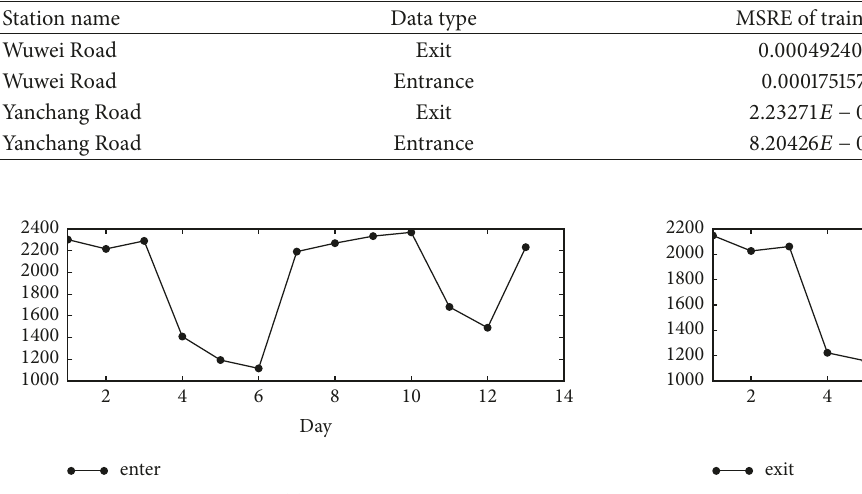
Table 11: Training error and test error of prediction on other rail transit stations.